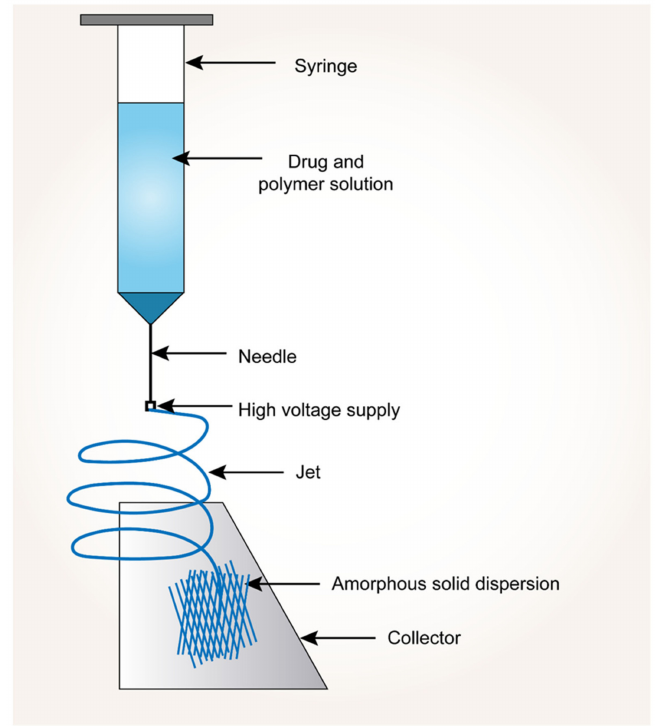
Figure 5. Process of electronanospinning